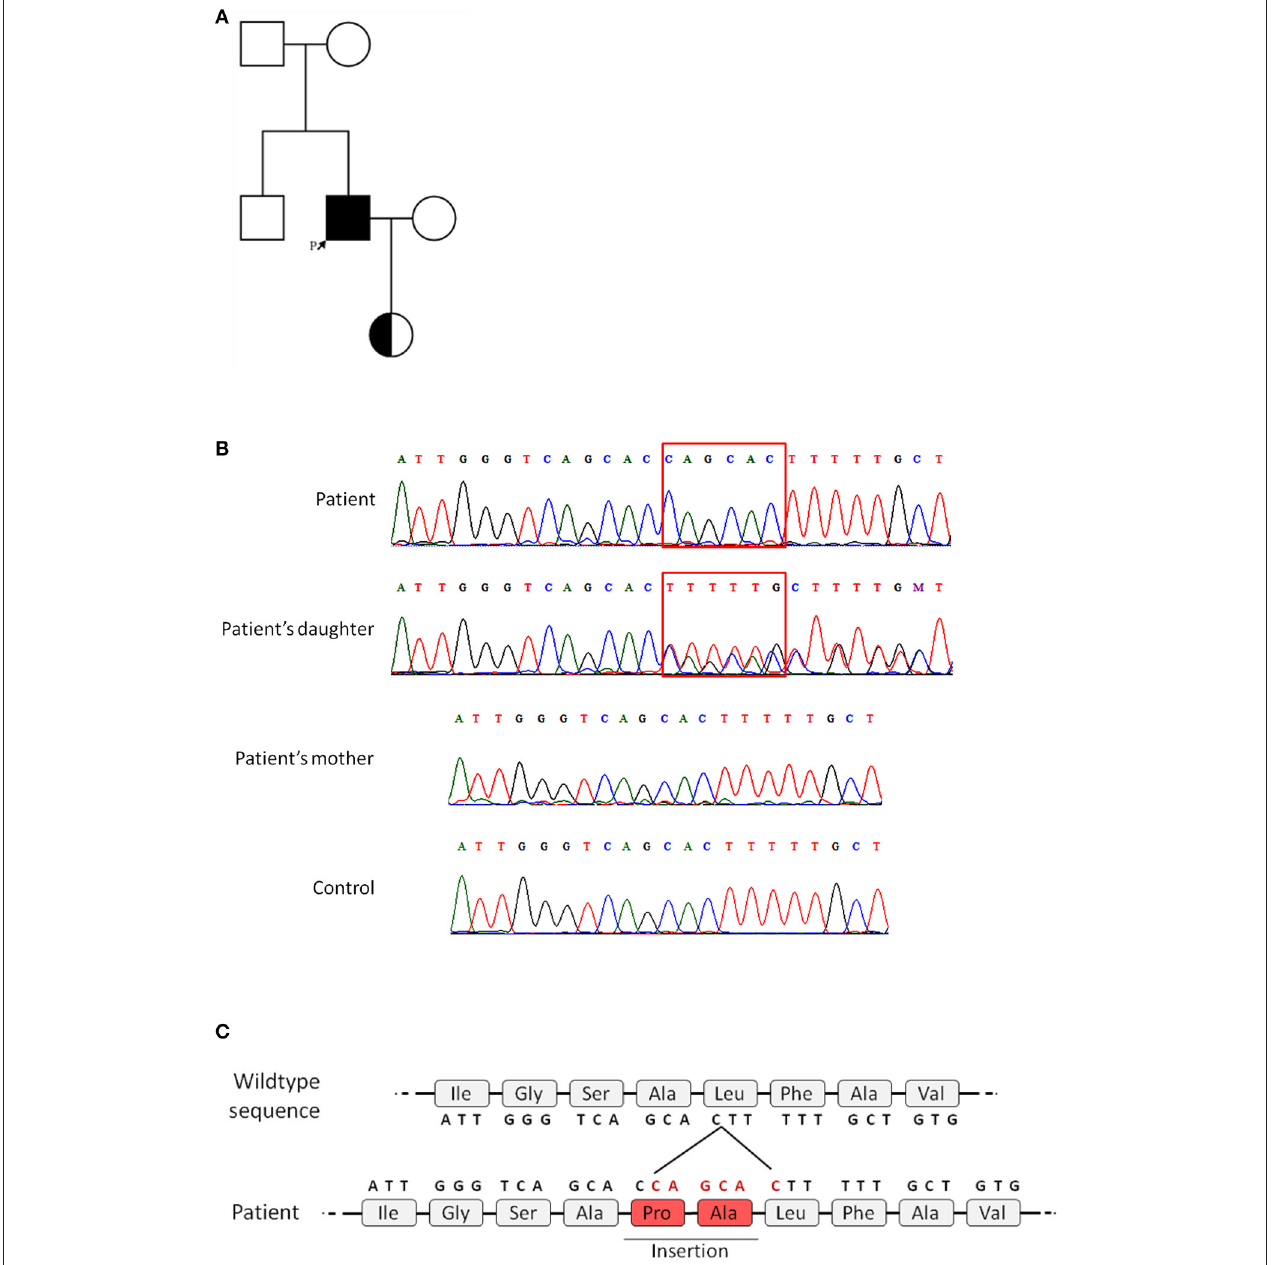
FIGURE 2 | Family pedigree and genetic analysis of the CD40L gene. Genetic analysis was performed on the patient and the patient’s daughter and mother by Sanger sequencing. All five exons of CD40LG were analyzed. (A) Family pedigree (the patient is indicated by the arrow). (B) Chromatogram showing the patient’s 6-nucleotide insertion in exon 1 and the heterozygous genotype of the patient’s daughter, in contrast to the patient’s mother and a healthy control. (C) Representation of the predicted insertion of 2-amino acids in the sequence of the mutated